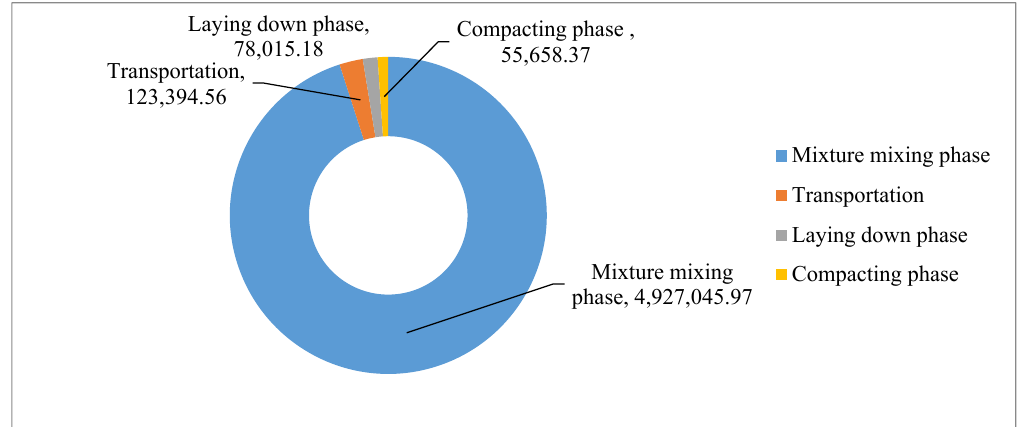
Figure 9. CO 2 e emission of different phases in asphalt course construction excluding raw materials production process (unit: kg).